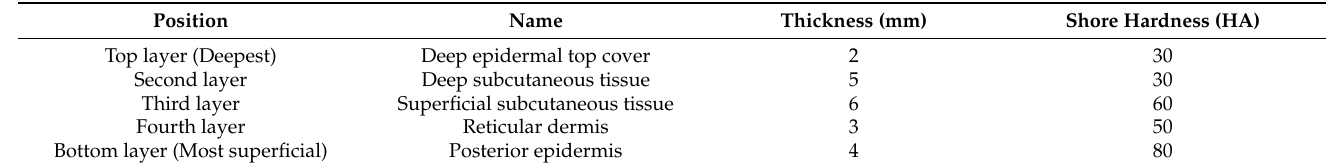
Table 2. The thickness and hardness of the five layers of the bionic heel